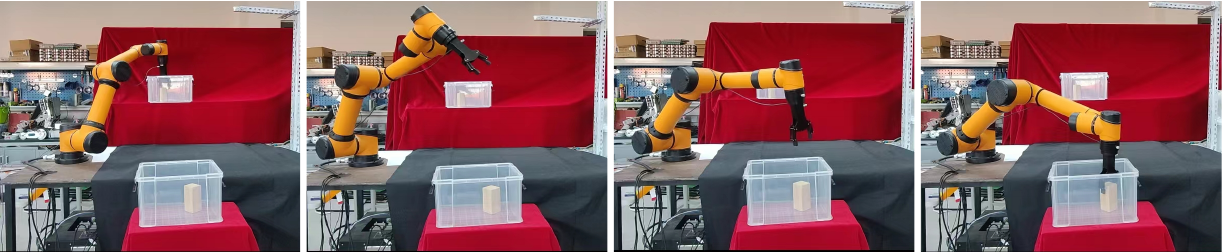
Figure 10. The starting position of AUBO − i5 when it is about to perform picking task.